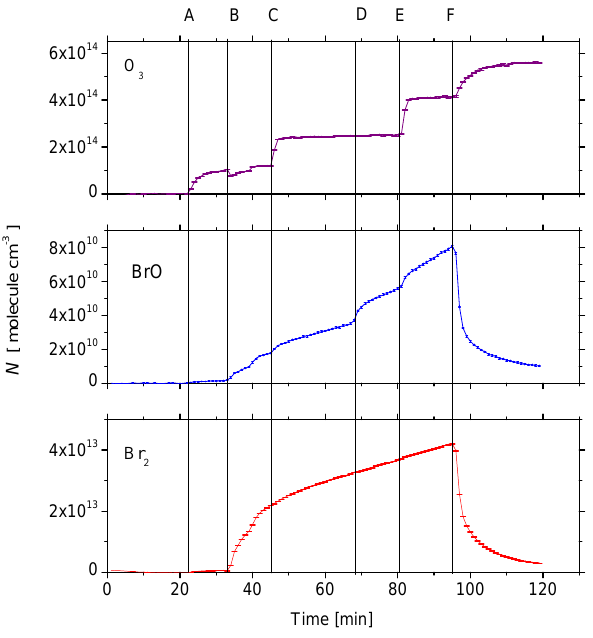
Fig. 10. Temporal dependence of the number density of O 3 , BrO, and Br 2 in the flow cell. Points A–F indicate changes in either the input concentrations or photolysis rate.